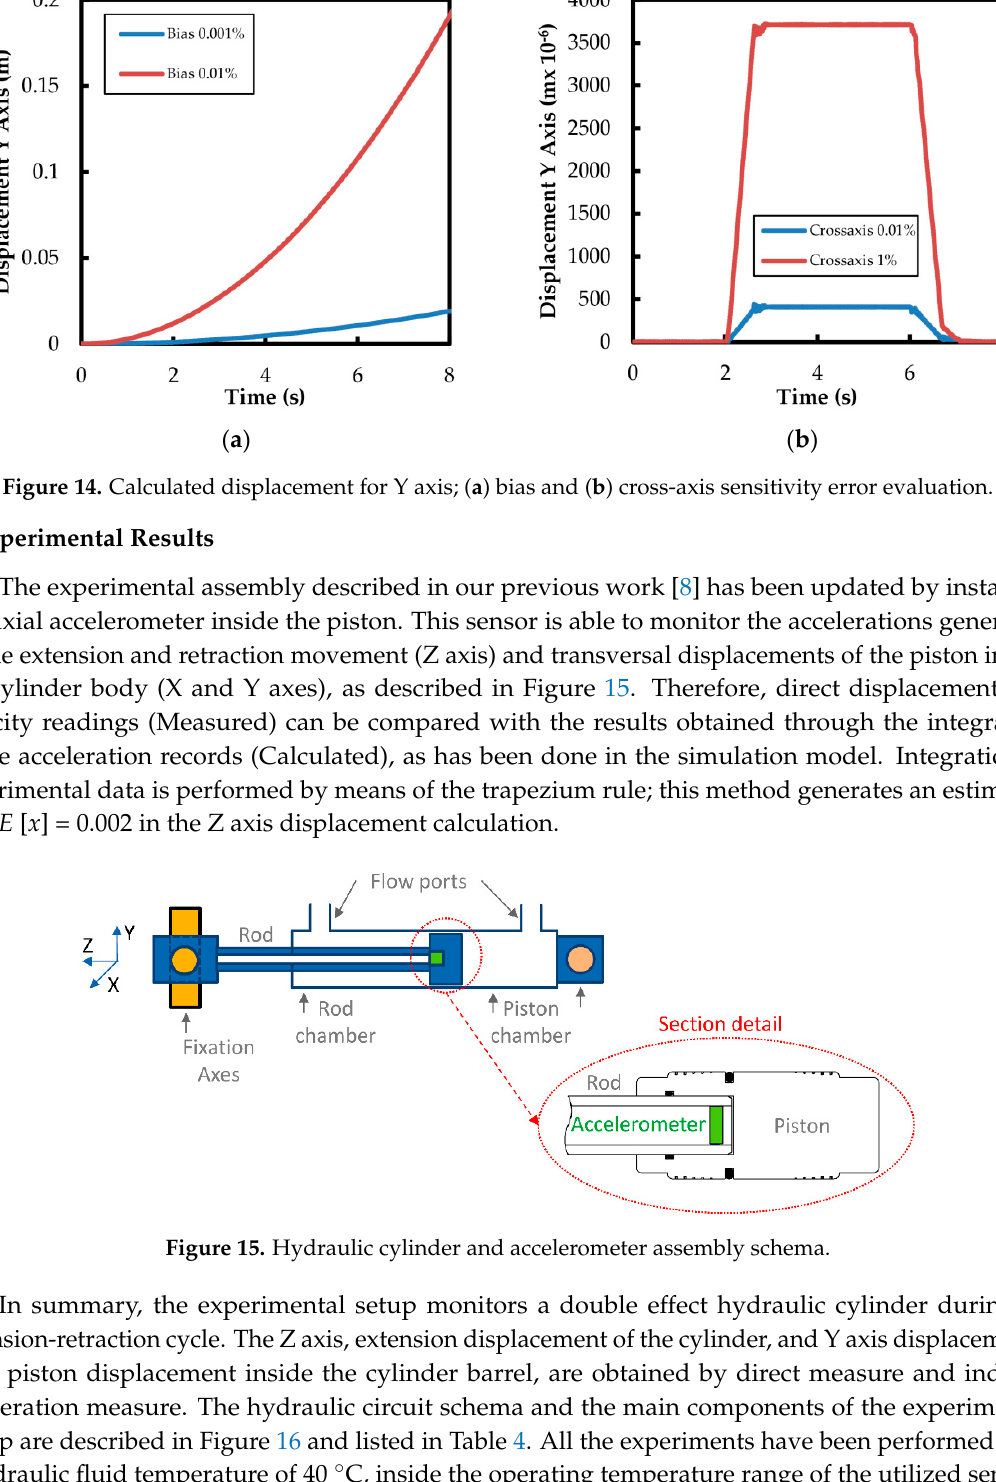
Figure 13. Calculated displacement for Y axis; ( a ) noise and ( b ) non-linearity error evaluation.